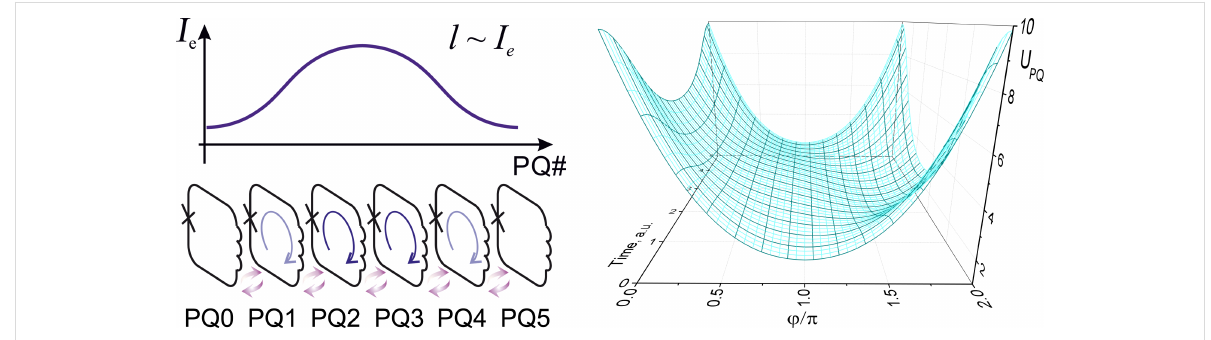
Figure 12: Logical state transfer in an array of magnetically coupled parametric quantrons under a driving current pulse I e , with corresponding change of the potential profile of a single cell in time. Violet arrows represent magnetic coupling.